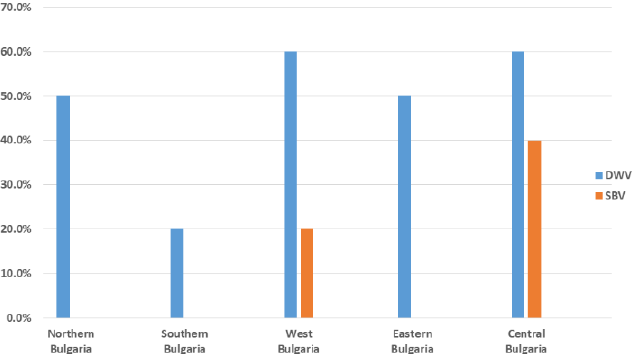
Figure 2. Frequency (%) of the positive (successfully amplified fragment) pollen samples (DWV and SBV) in different regions of the country. The analysis included a total of 27 pollen samples: directly provided by beekeepers ( n = 12), purchased from the trade markets ( n = 5), or obtained from honey- combs (bee bread, n = 10).